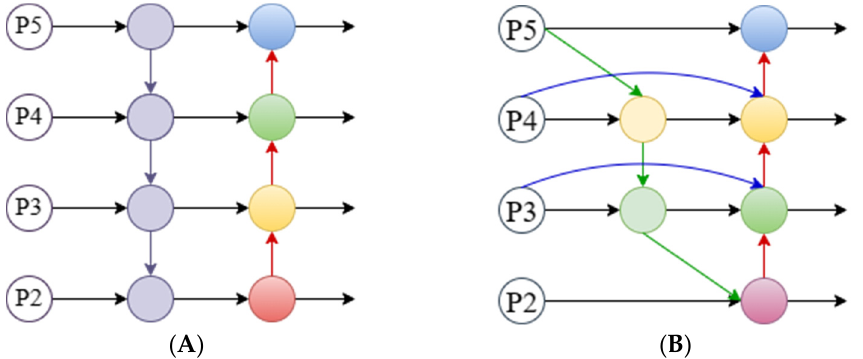
Figure 8. Schematic diagram of Neck network structures. PANet ( A ) and BiFPN ( B ).